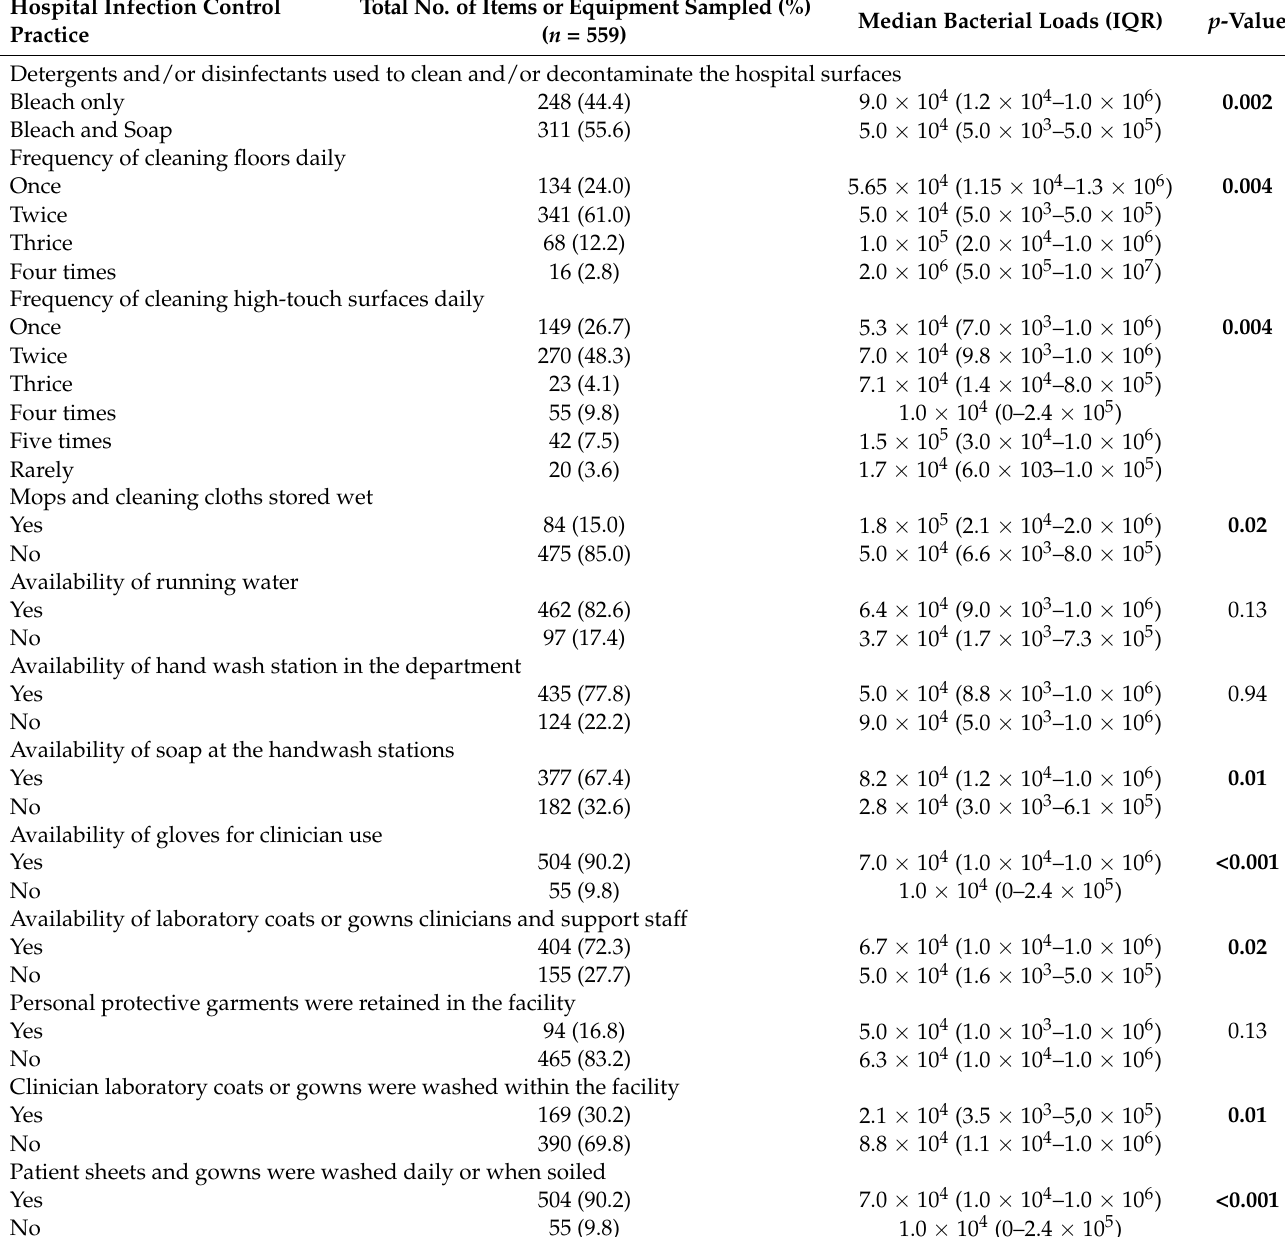
Table 1. Characteristics of IPC practices and bacterial